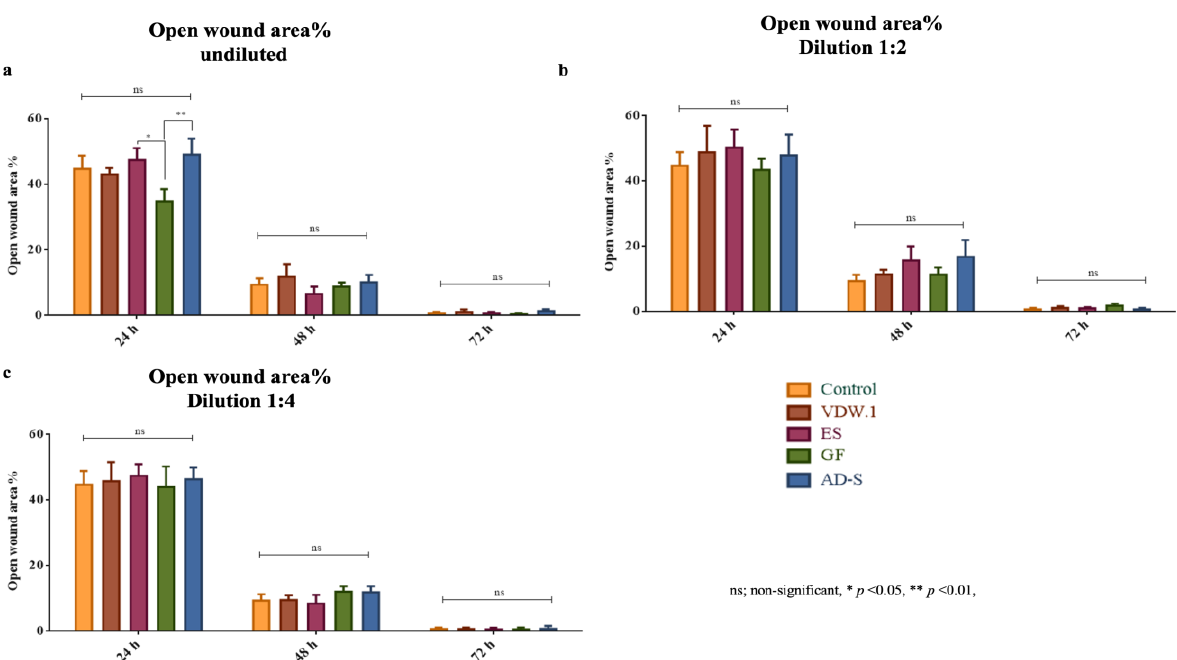
Figure 3. Percentage of open wounds in eluates of the different sealers used during 24 h, 48 h, and 72 h, given as means and standard deviations. ( a ) Undiluted eluates. ( b ) Dilution 1:2. ( c ) Dilution 1:4. VDW.1; VDW.1Seal, ES; Endosequence BC Sealer HiFlow, GF; GuttaFlow-2, AD-S; ADSeal.